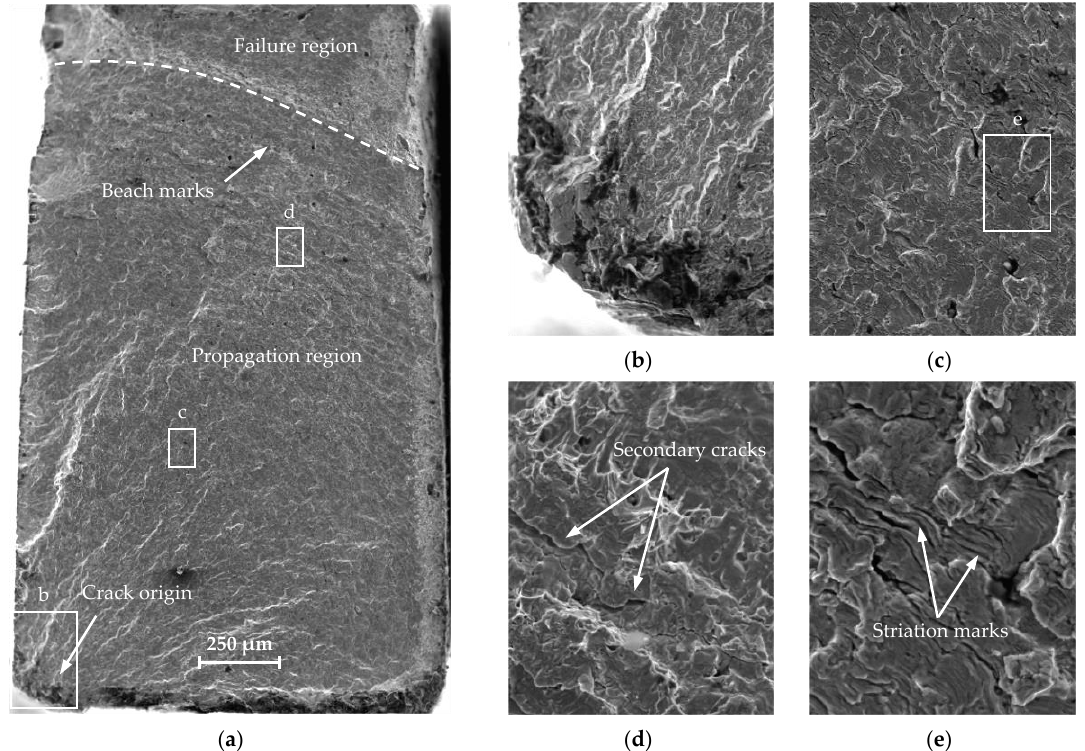
Figure 10. Fracture surfaces of mini-specimen made of S235JR steel: ( a ) overall surface; ( b ) crack origin; ( c ) propagation region; ( d ) secondary cracks; ( e ) striation marks.